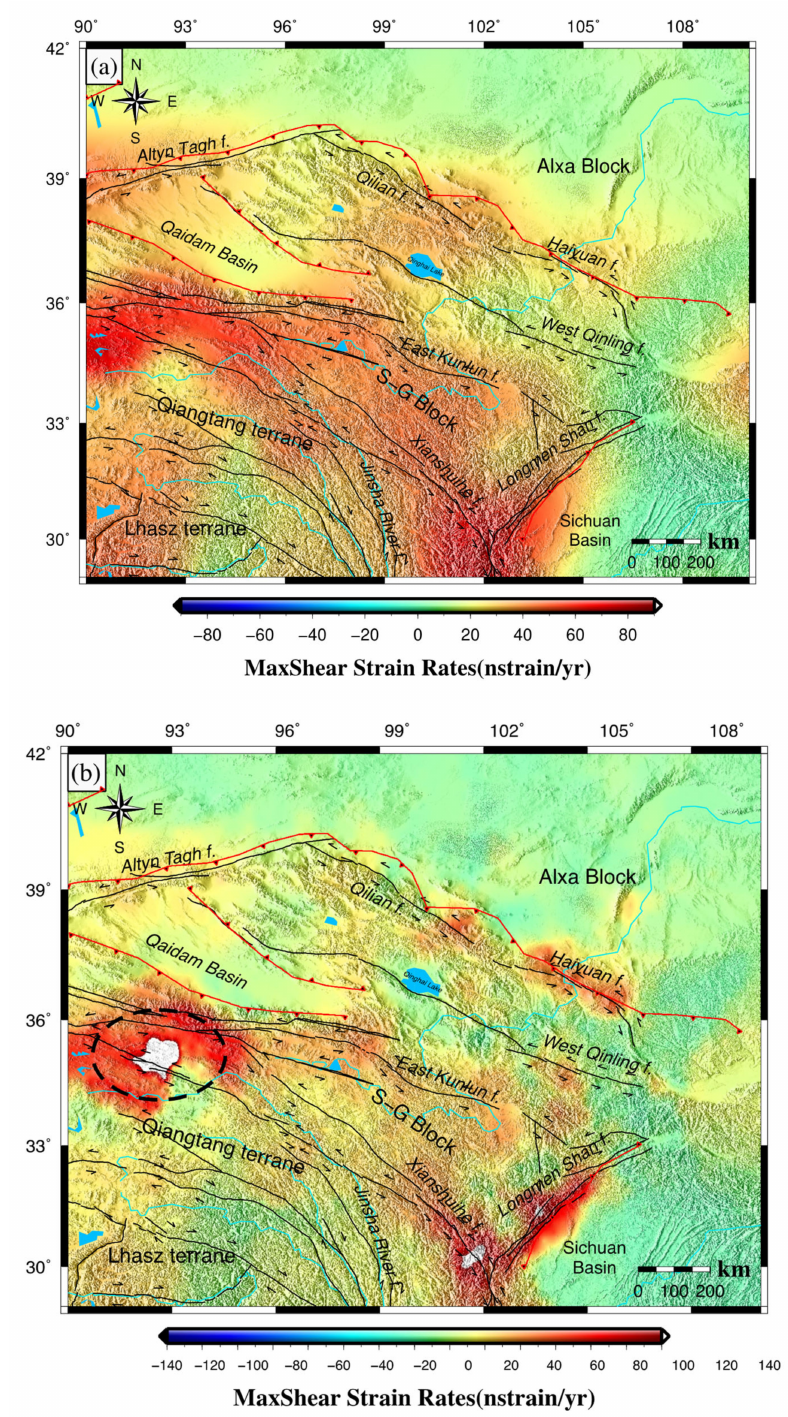
Figure 10. GPS-derived rates of maximum shear strain as a continuous background color pattern using ( a ) the grid-distance weighted routine with α = 100 km, and ( b ) the grid-nearest neighbor routine with 12 neighbors and a maximum radius = 300 km, respectively. The color bars are different in each sub-figure for the identification of regional strain patterns. The blue-dashed ellipse in sub-figure ( b ) represents the area with abnormal rates of maximum shear strain